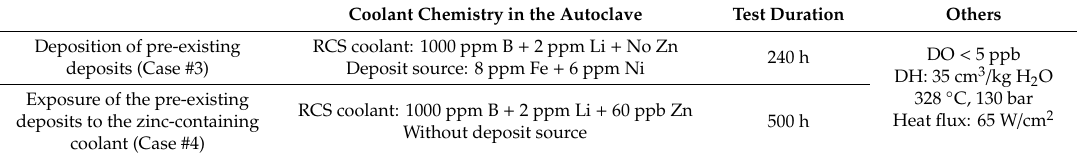
Table 3. Experimental conditions for the tests for zinc incorporation into pre-existing fuel deposits. Coolant Chemistry in the Autoclave Test Duration